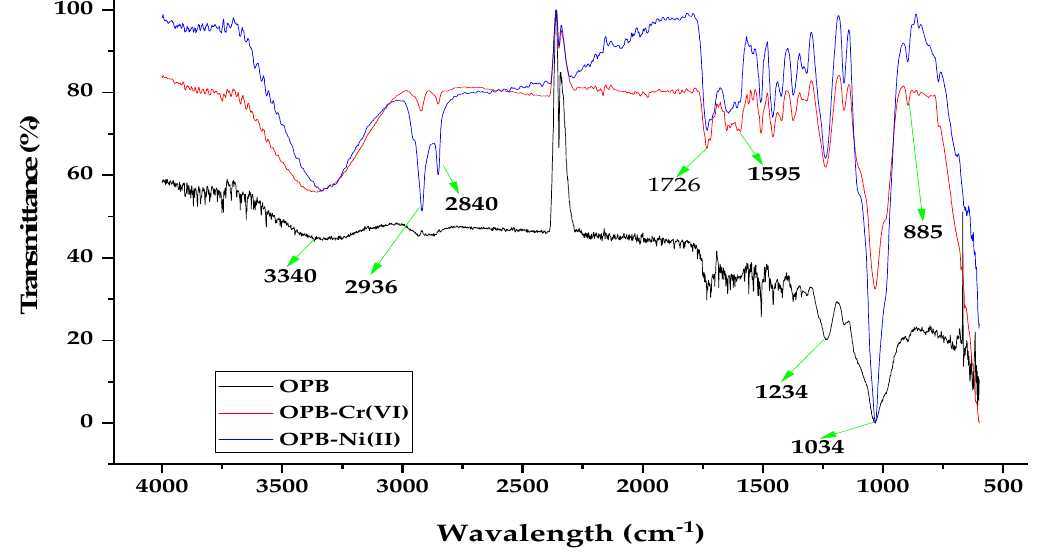
Figure 2. OPB FTIR before and after Cr(VI) and Ni(II) adsorption.